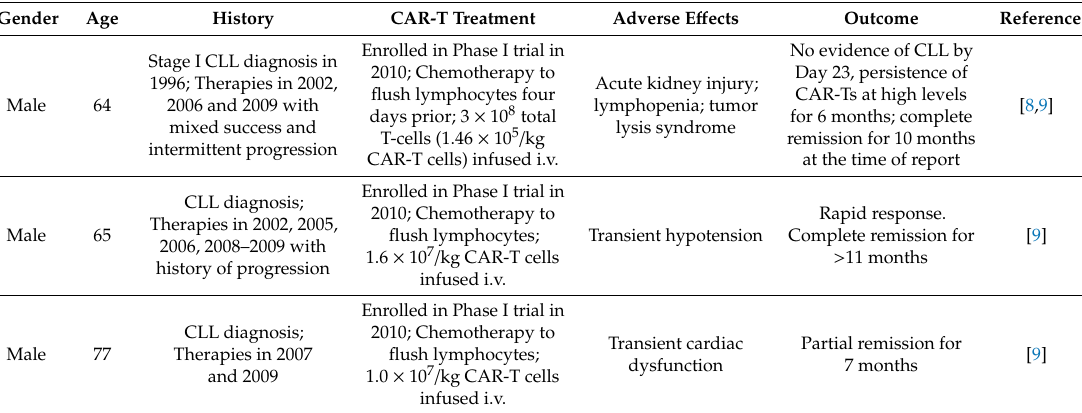
Table 2. Early clinical study on expansion and persistence of CAR-Ts in adult Chronic Lymphocytic Leukemia